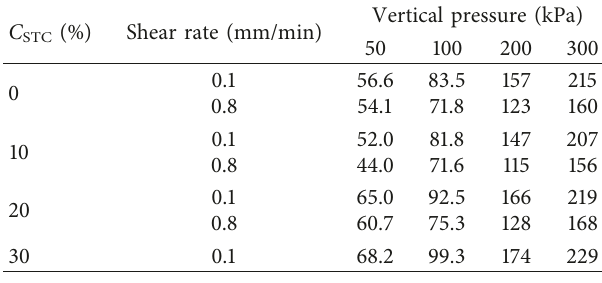
Table 3: Effects of shear rates on shear strength of mixtures. C STC (%)